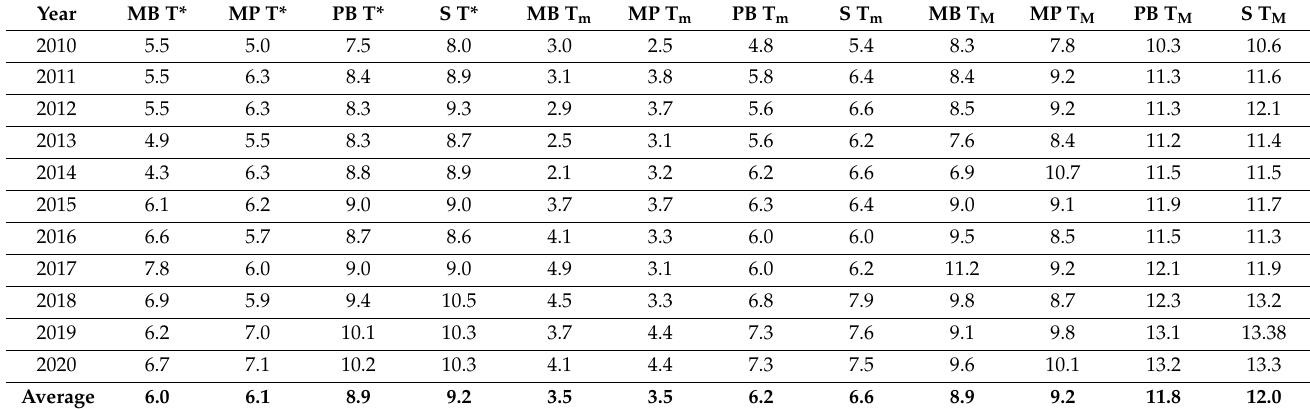
Table 4. Average annual temperatures ( T* ), average annual minimum temperatures ( T m ), and average annual maximum temperatures ( T M ) at the weather stations ( MB , MP , PB , S ).